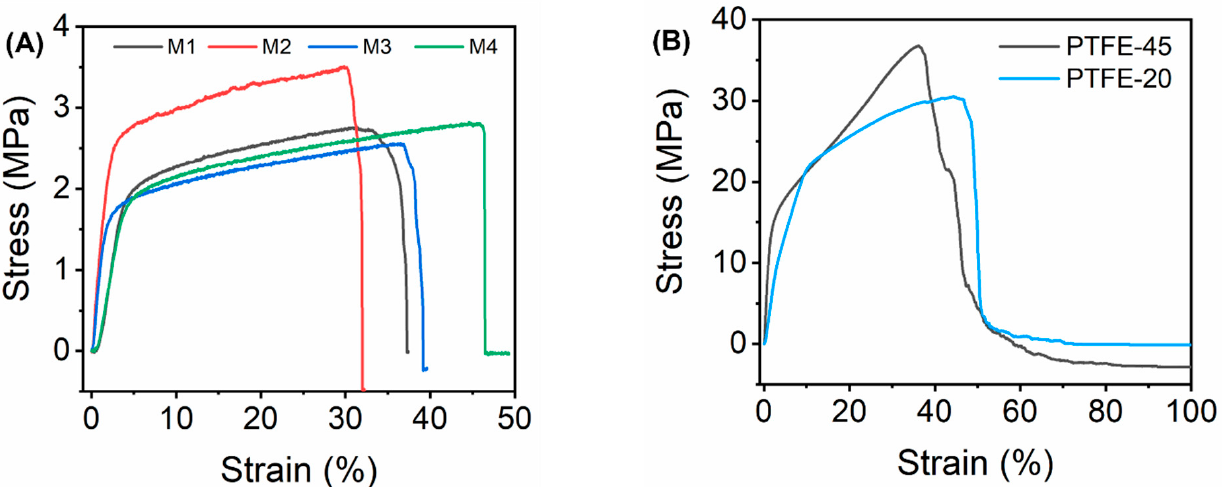
Figure 4. Stress–strain plots of ( A ) the as-synthesised membranes and ( B ) the commercial membranes. Table 3. Young’s modulus of the as-synthesised PVDF membranes and commercial PTFE membranes.